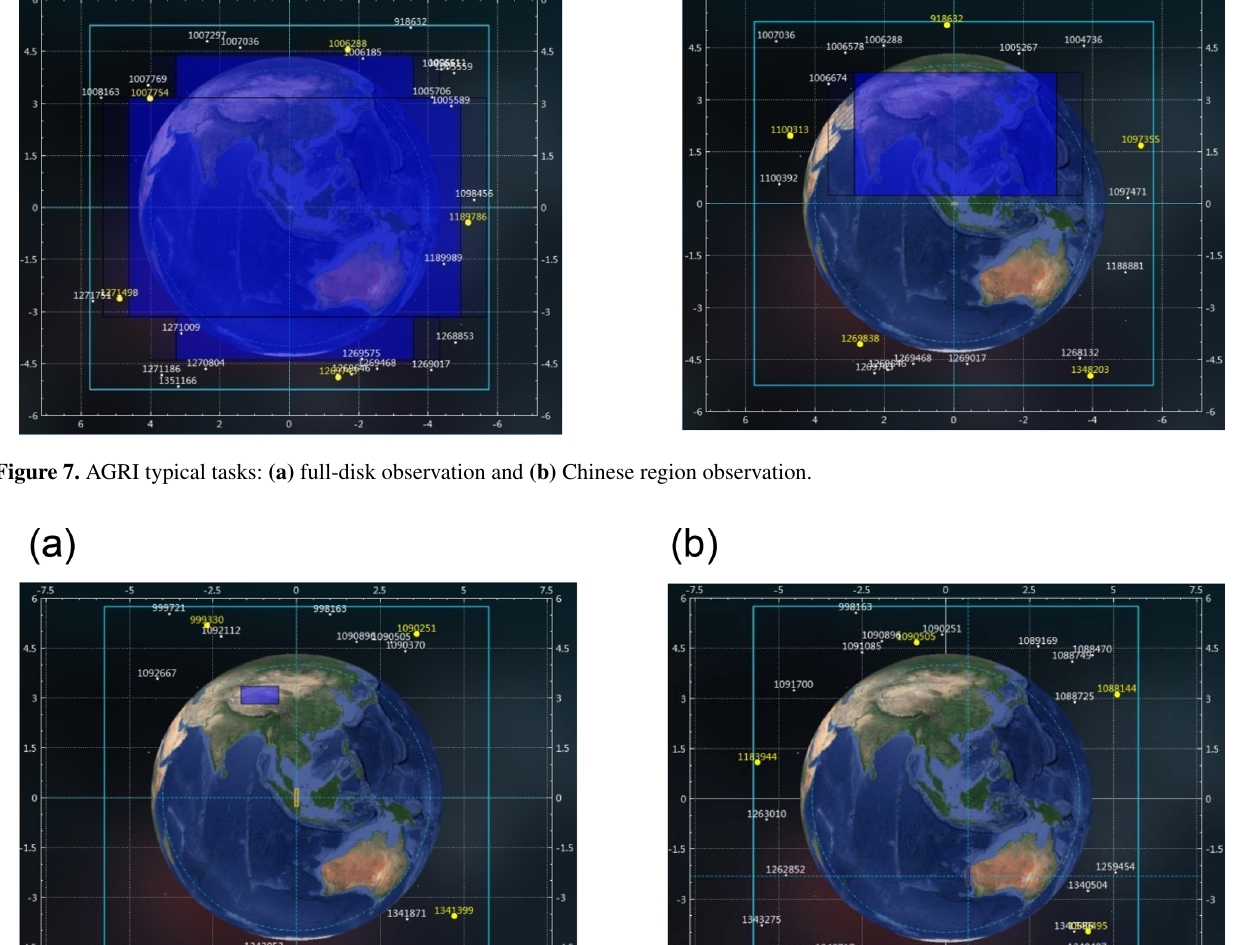
From March 2017 to March 2018, the software of the